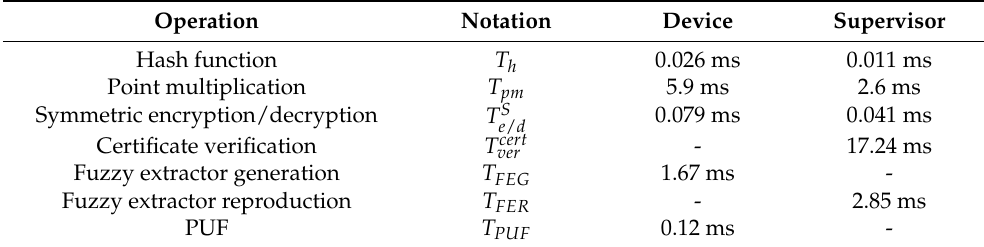
Table 6. Operation cost symbol and execution time.